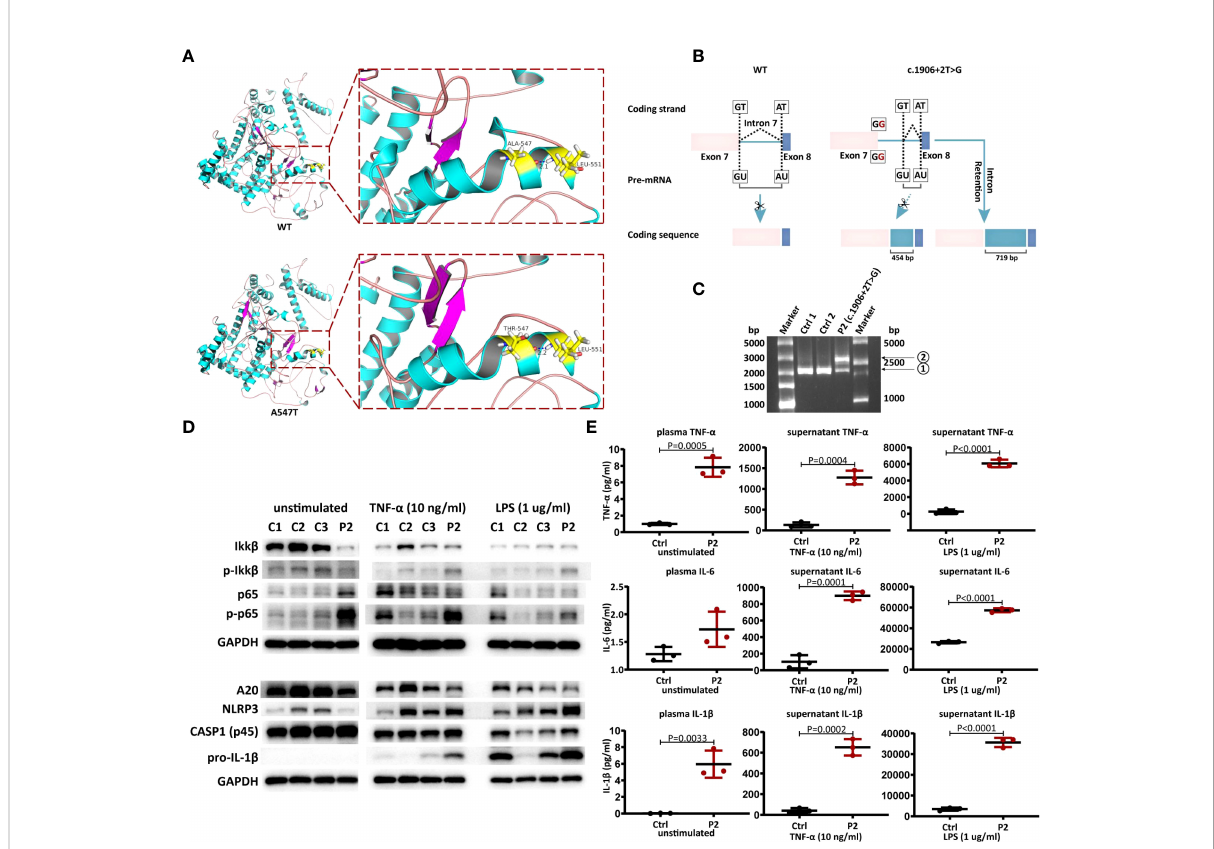
FIGURE 2 Pathogenicity validation of novel TNFAIP3 variants. (A) The predicted 3D structure of wild type (WT) and A547T variant of A20 protein. (B) Schematic view of Complementary DNA analysis of WT and the splice site mutation c.1906+2T>G. (C) Agarose gel electrophoresis result. P2, the proband of the second family; Ctrl, healthy controls. (D) Western blot analysis of A20 expression, NF- k B and NLRP3 in fl ammasome signaling pathway in PBMCs from P2 and controls. (E) Cytokine (TNF- a , IL-6 and IL-1 b ) levels in plasma and culture supernatants of PBMCs from P2 and controls (mean ± SD from three independent experiments in P2 and n=3 controls, P values were determined by unpaired two-tailed Student ’ s